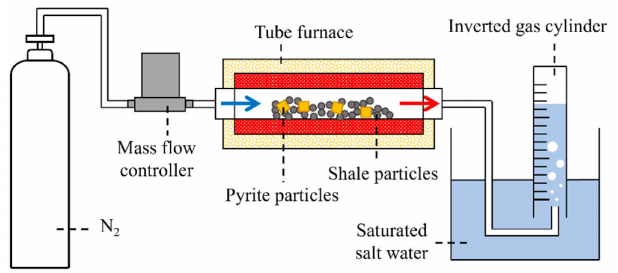
Figure 1. This is a figure. Schemes follow the same